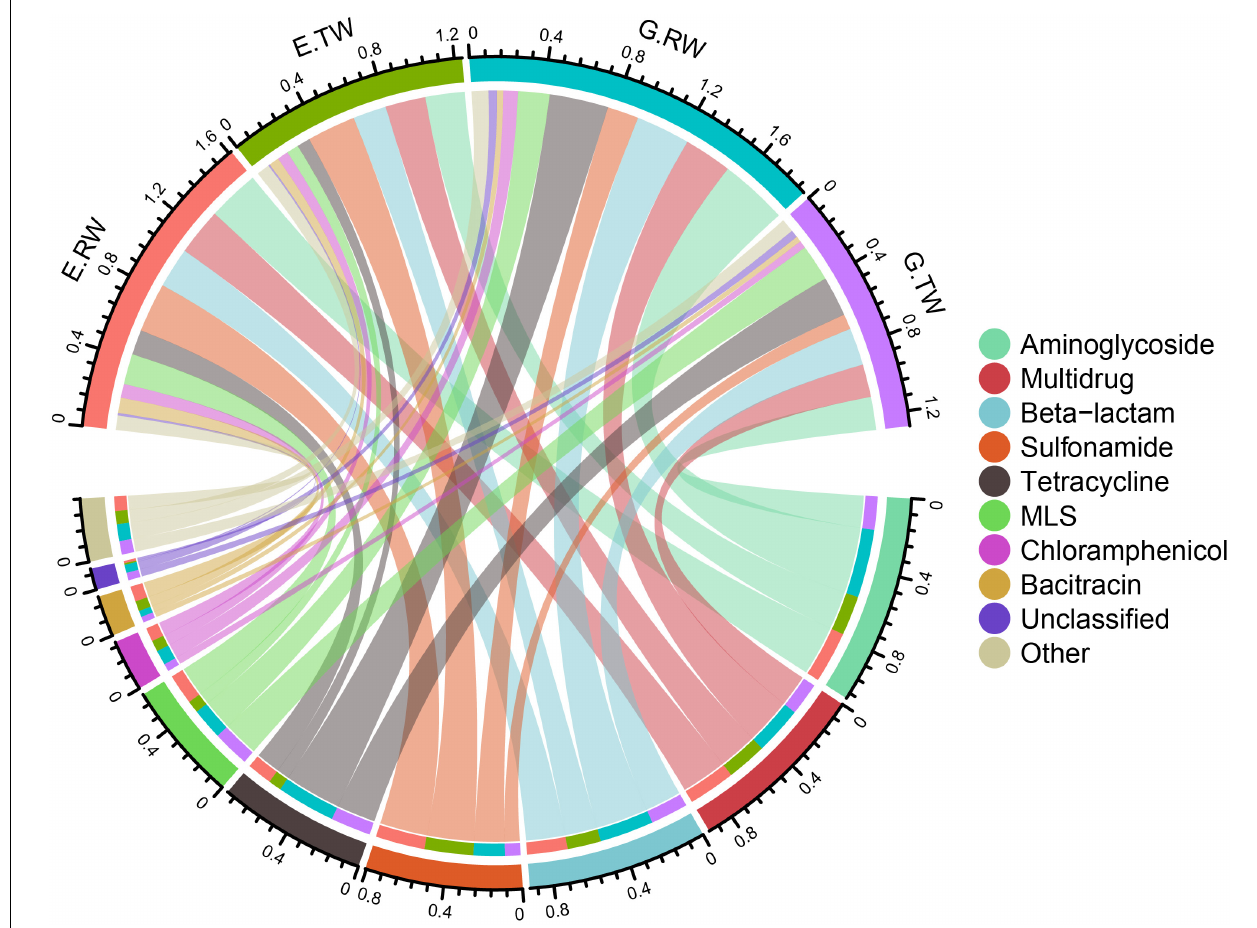
FIGURE 4 | Total ARGs in the four sampling locations. A total of 20 ARG types were identified in 12 samples of hospital wastewater, with the 10 most abundant ARGs shown in the Circos plot. The top half of the plot depicts the abundance of the samples, the bottom half is the abundance of the 10 ARGs, the connecting lines indicate the composition of ARGs in each sample and the distribution of samples in each ARG